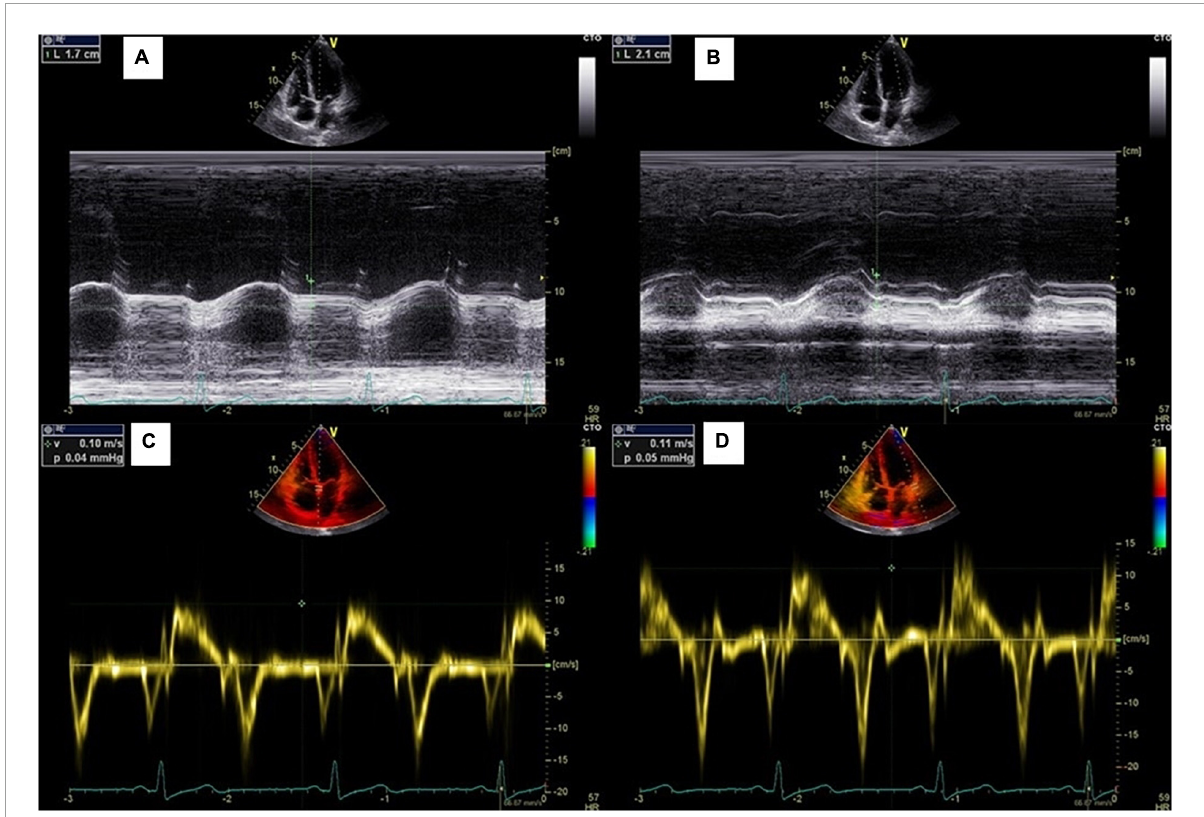
FIGURE2 Measurements of mitral annular plane systolic excursion. (A,B) Septal and lateral MAPSE measured by M mode echocardiography; (C,D) Septal and lateral S’ measured by pulsed-wave tissue